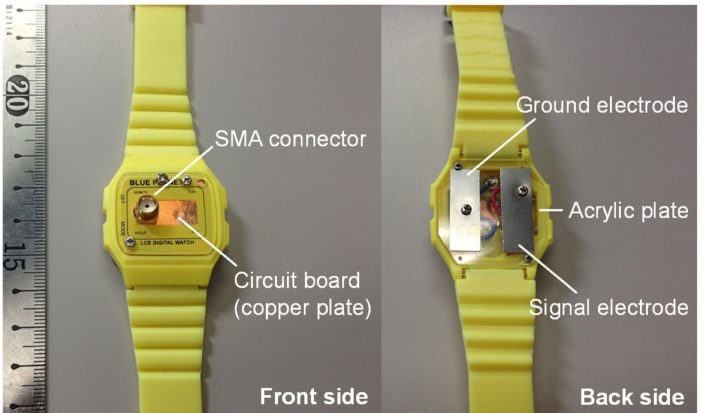
Figure 5. Make-up of the wearable antenna